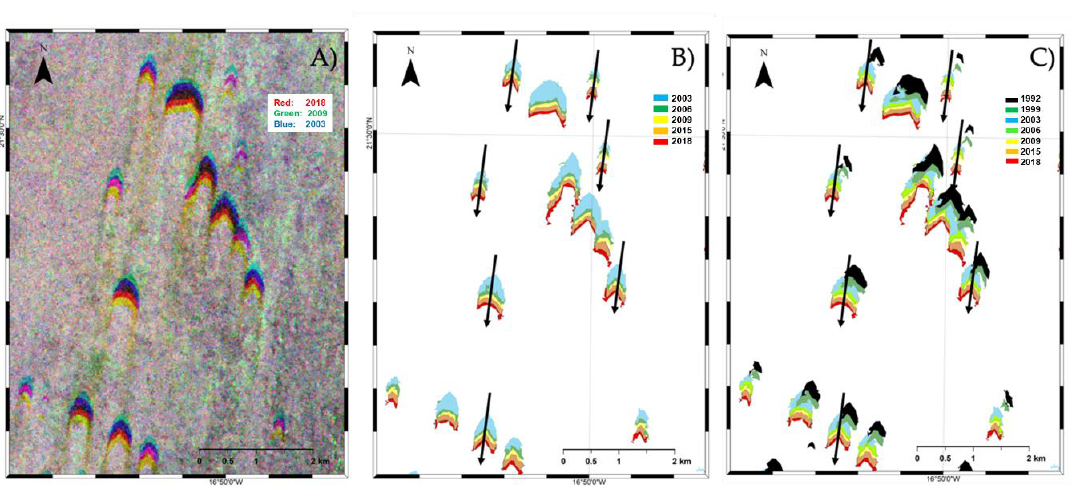
Figure 17. ( A ) False RGB composition of SAR images acquired in 2018 (Red), 2009 (Green) and 2003 (Blue). ( B ) Polygons of the dunes detected for Envisat and Sentinel-1 data with movement direction indicated by black arrows. ( C ) Polygons of the dunes detected for all periods, including ERS-2 SAR, which appear misaligned for the years 1992 and 1999 (black and dark green polygons, respectively).